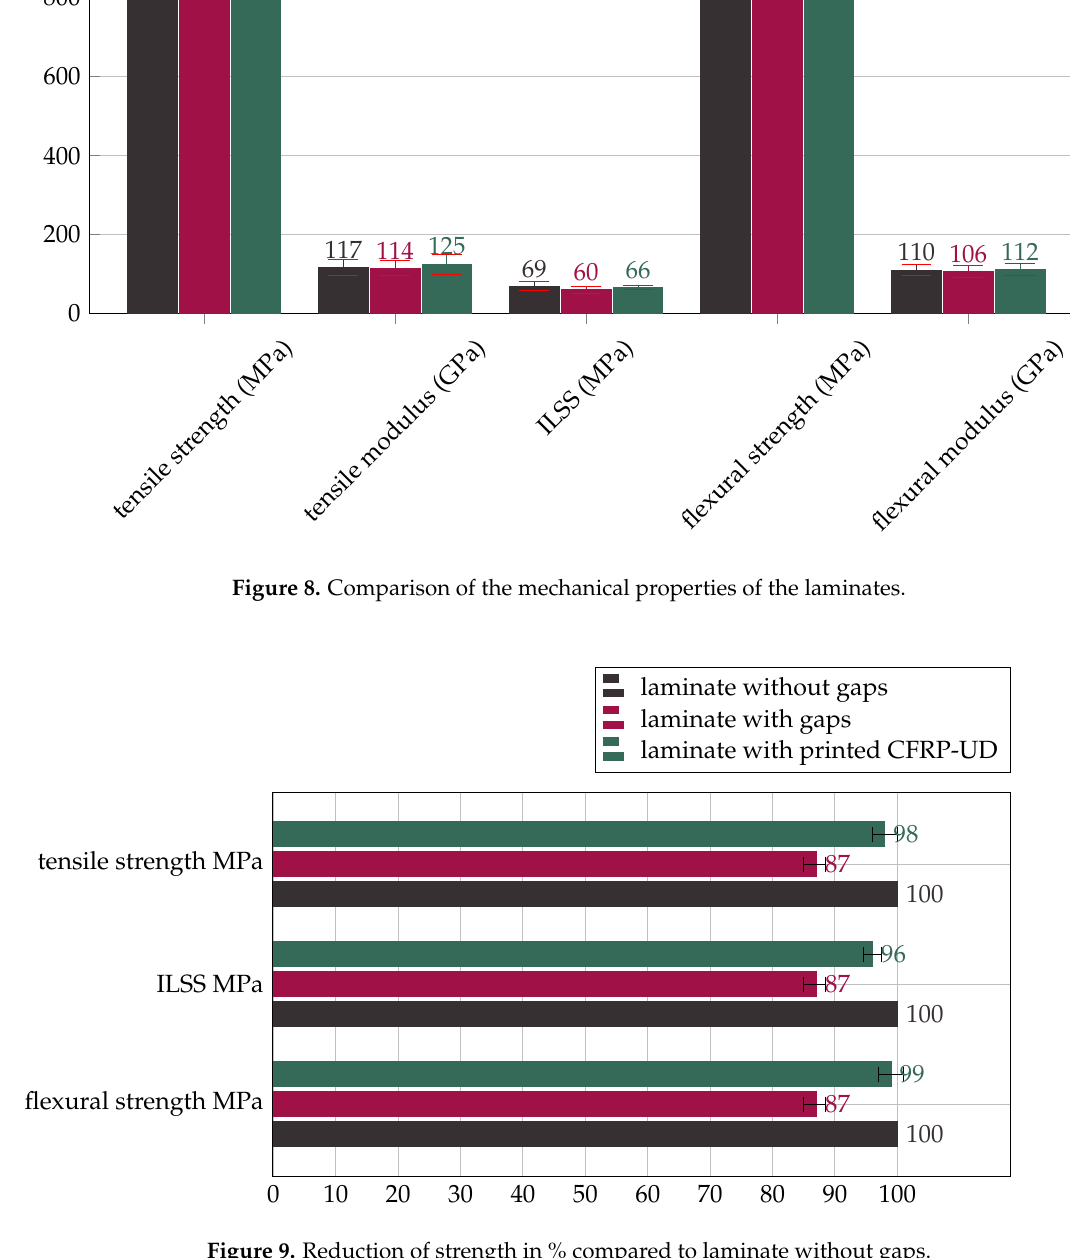
Figure 9. Reduction of strength in % compared to laminate without